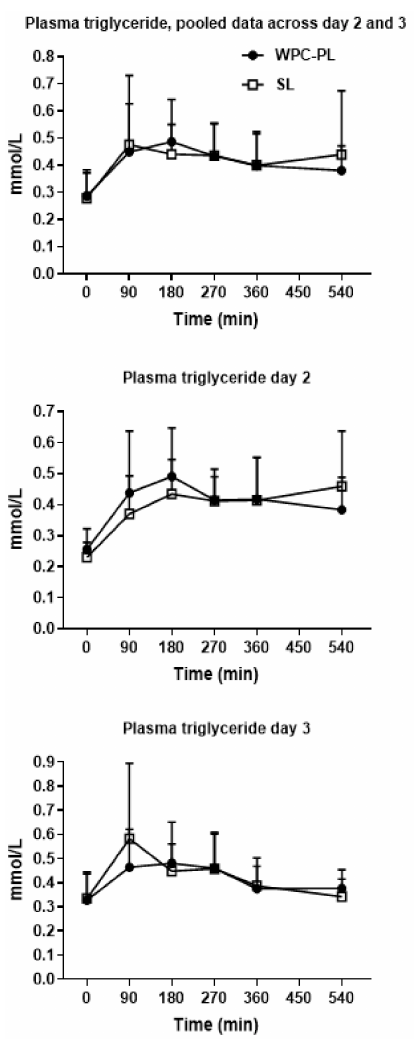
Figure 4. Triglyceride levels in plasma, mmol/L, as pooled data across day two and three in upper panel (WPC-PL n = 16, SL n = 18), and data from day two in middle panel (WPC-PL n = 9, SL = 9) and three in lower panel (WPC-PL n = 9, SL n = 7) separately. Values presented as means ±